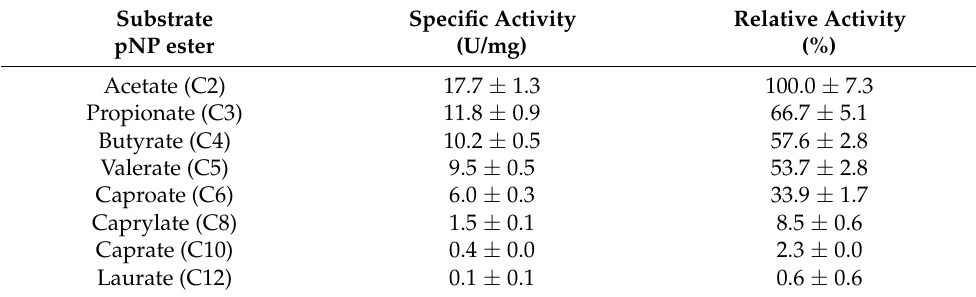
Table 1. Substrate specificity of the purified Est6.